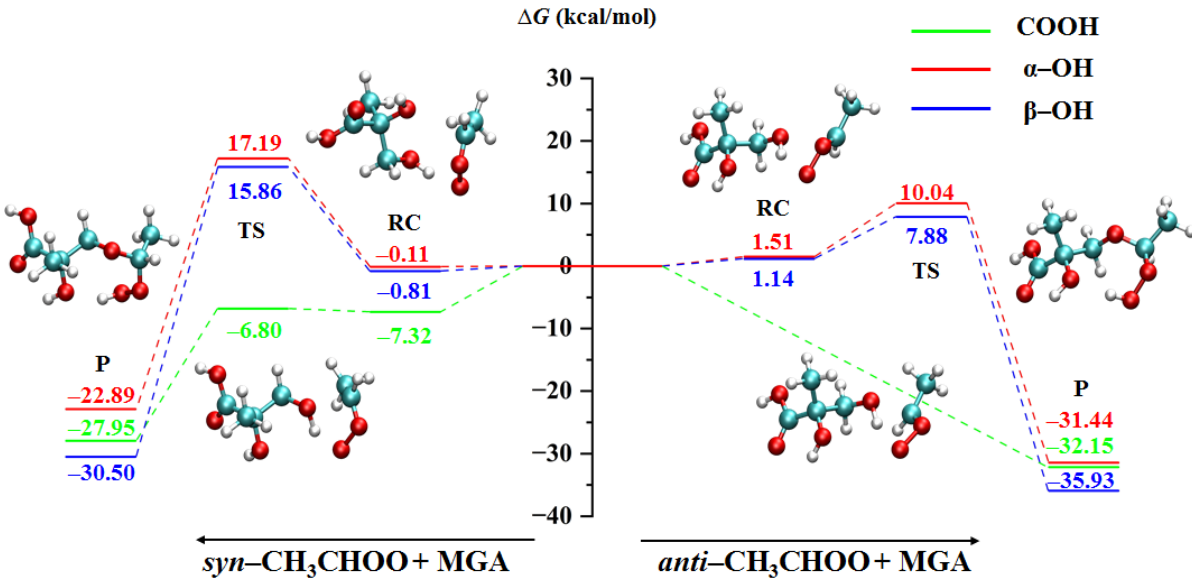
Figure 2. The minimum energy pathway for the CH 3 CHOO + MGA reactions (RC: reaction complex, TS: transition state, P: product).